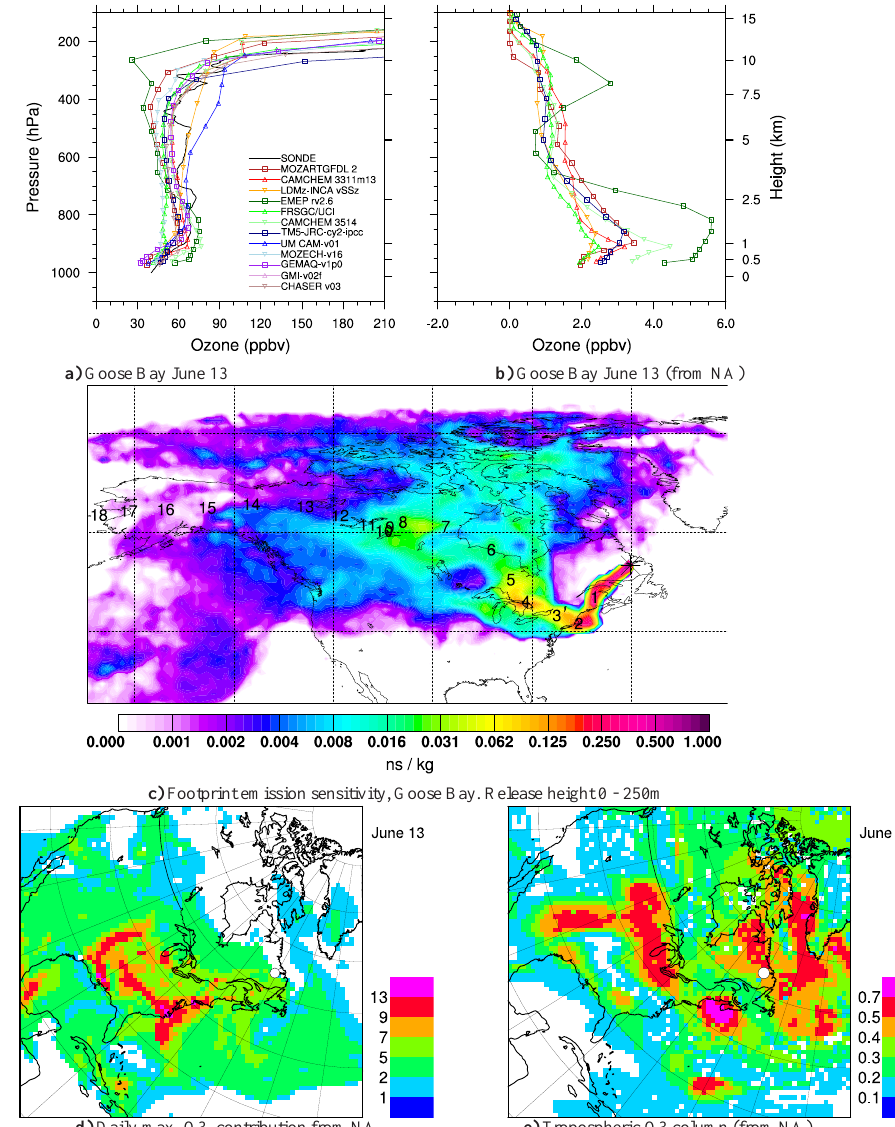
Fig. 12: All panels for June 13, 12 UTC. a) Ozone sounding and calculated vertical profiles for the 12 models listed in Ta- ble 1 in ppb. b) Calculated difference SRref - SR20%NA in ppb for the 7 models, showing the effect of a 20% reduction of North American emissions. c) FLEXPART footprint emission sensitivity for Goose Bay for the 0 - 250m layer in ns/kg (nanoseconds/kg). The asterisk marks the position of the ozonesonde site. d) Difference (SRref - SR20%NA) in daily maxi- mum surface-ozone in ppb calculated with the EMEP model. e) Difference (SRref - SR20%NA) in tropospheric ozone column (DU) calculated with the EMEP model. White circle marks the position of Goose Bay in d) and e).